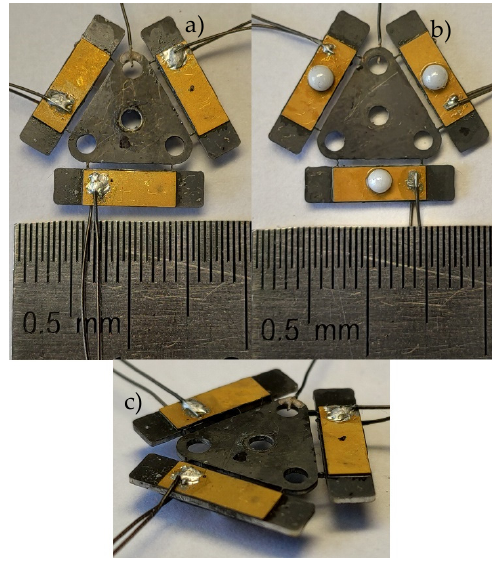
Figure 13. Prototype of the platform; ( a )—top view, ( b )—bottom view, ( c )—side view.